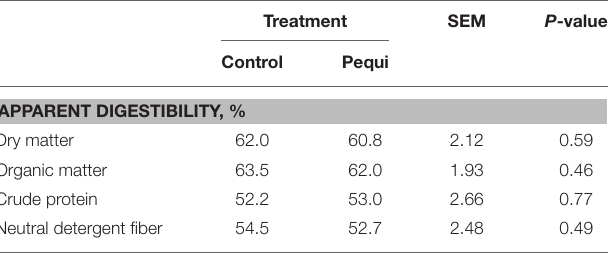
TABLE 6 | Effect of pequi oil on apparent digestibility of nutrients in wethers fed a hay-based diet. Treatment